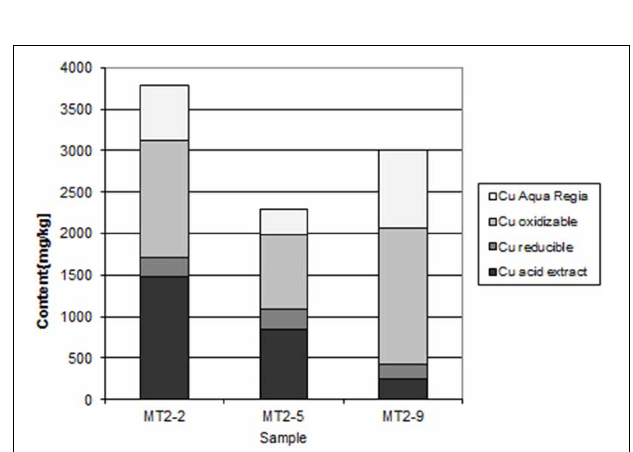
FIGURE 6 | Sequential extraction of Chambishi samples: Fe.